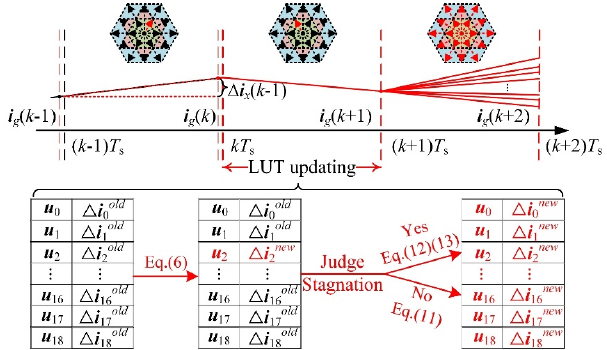
Figure 4. Proposed current gradient updating method.